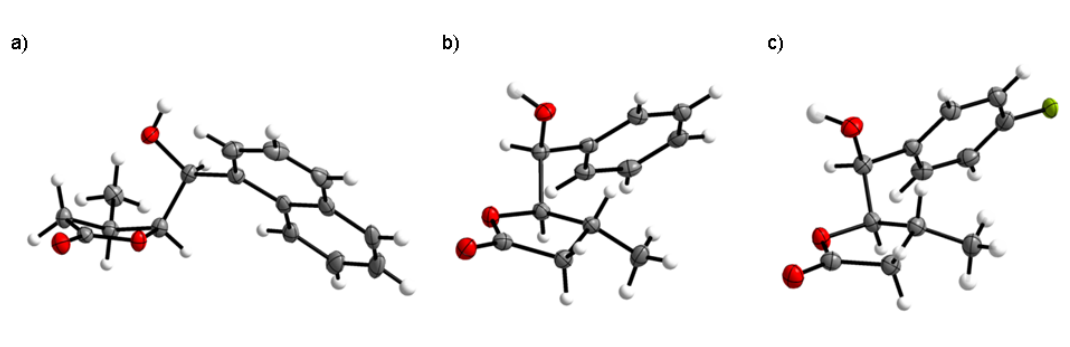
Figure 6. The crystalline structure of: ( a ) cis - δ -hydroxy- γ -lactone 1 3a; ( b ) trans - δ -hydroxy- γ -lactone 1 2b; and ( c ) trans - δ -hydroxy- γ -lactone 1